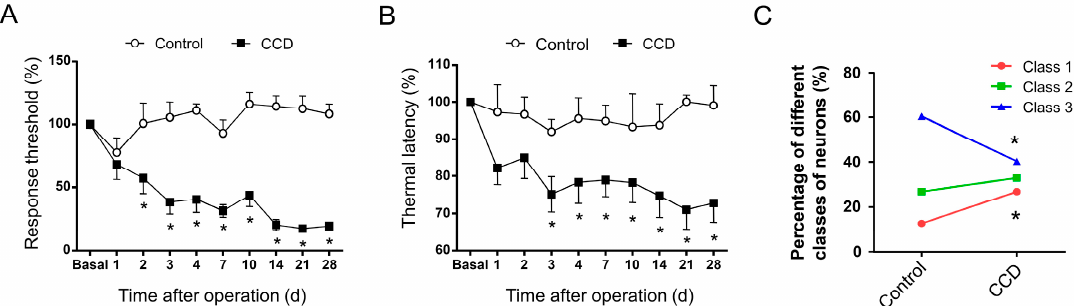
Figure 5. ( A , B ) Development of mechanical hypersensitivity and thermal hyperalgesia following chronic compression of DRG (CCD) in rats; ( A ) Mechanical hypersensitivity developed in the ipsilateral hind paws from CCD rats but not in sham controls. Note that paw withdrawal mechanical threshold (PWMT) to von Frey hairs decreased dramatically from the second day following chronic compression of L4/L5 DRG ( n = 10; Two way ANOVA, F(1,150) = 218.5, p < 0.0001; in multiple comparisons, * p < 0.05 vs. Control); ( B ) Thermal hyperalgesia was observed by measuring paw withdrawal thermal latency (PWTL) to radiant heat in CCD rats and sham controls for ipsilateral hind paws. Note that PWTL significantly decreased in CCD rats ( n = 10; Two way ANOVA, F(1,140) = 41.67, p < 0.0001; in multiple comparisons, * p < 0.05 vs. Control), but not in sham group with a similar time course with mechanical hypersensitivity; ( C ) Upon chronic compression of lumbar DRGs, the percentage of neurons showing different classes of excitability underwent plastic changes. The proportion of Class 1 and Class 3 neurons reciprocally displayed marked increase and decrease (Class 1: Pearson χ 2 test, F = 9.842, * p = 0.002; Class 3: Pearson χ 2 test, F = 12.321, * p < 0.001). Class 2 neurons did not show obvious alteration ( n = 22–48, Pearson χ 2 test, F = 1.338, p = 0.247). All data are expressed as mean ± S.E.M.